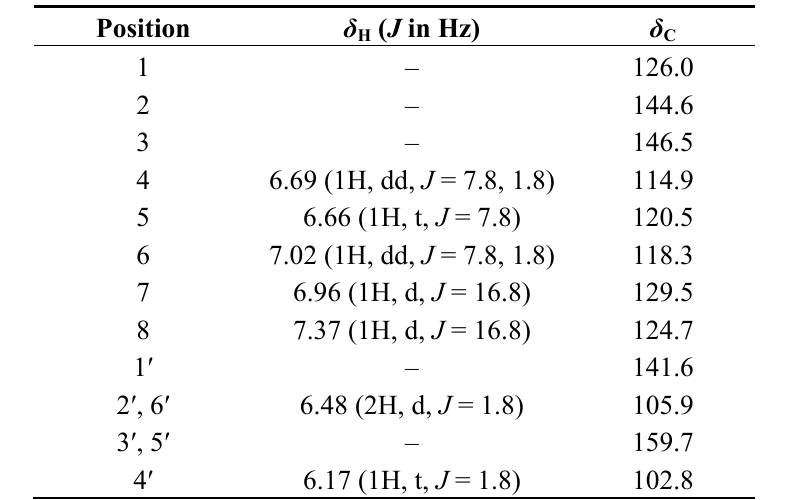
Table 3. 1 H-NMR (600 MHz) and 13 C-NMR (150 MHz) spectra data of compound 4 OD, J in Hz, δ in (in CD 3